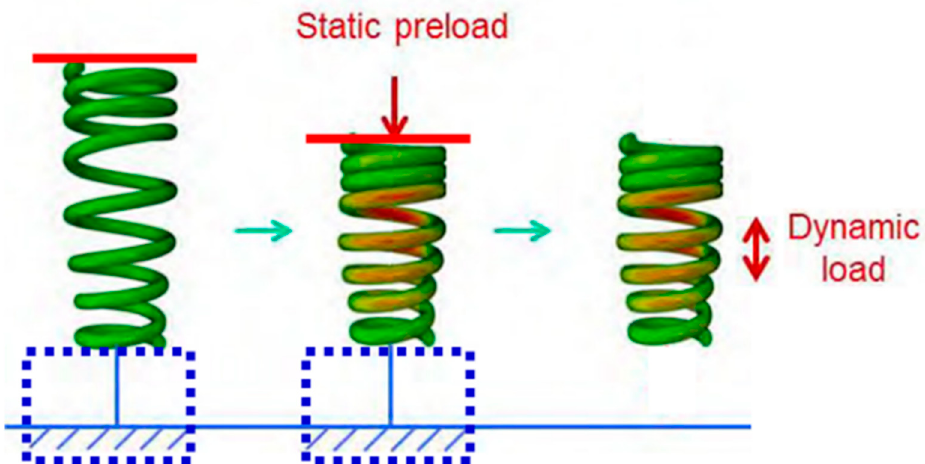
Figure 8. Analysis of spring properties using the Model Activation/De-Activation method [26]. In force/boundary conditions of general finite element analysis, the analysis ends when the spring is compressed, as shown in the middle figure. When the area of force applied (red-line) and the boundary (blue dash box) are de-activated after analysis, the actual spring characteristics, in which the string stressed by deformation returns to its original shape, may be predicted.